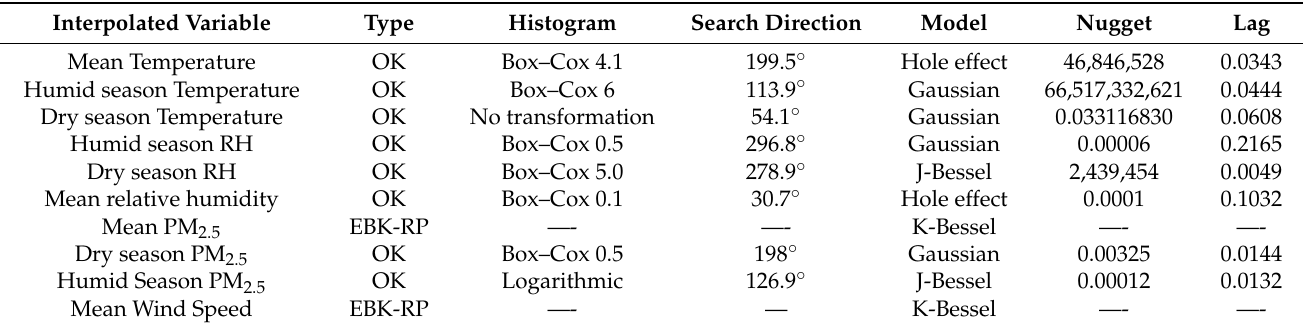
Table 5. Data setting and parameters used for interpolation of each variable. OK means ordinary Kriging and “EBK-RP” means empirical Bayesian kriging regression prediction.